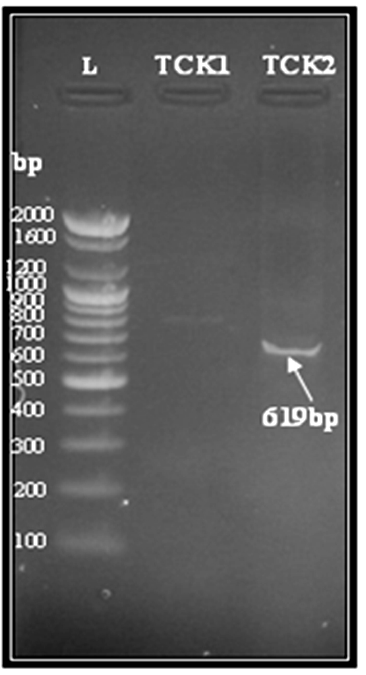
gene (619 OXA-1 gene. Lane OXA-1